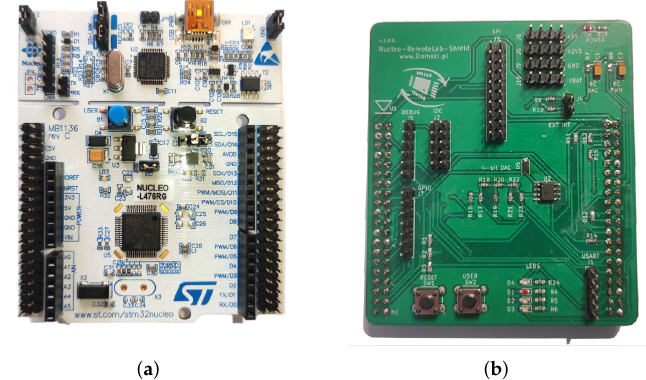
Figure 3. Nucleo-L476RG development board with expansion shield. ( a ) Photograph of the Nucleo- L476RG development board; ( b ) shield for Nucleo-L476RG